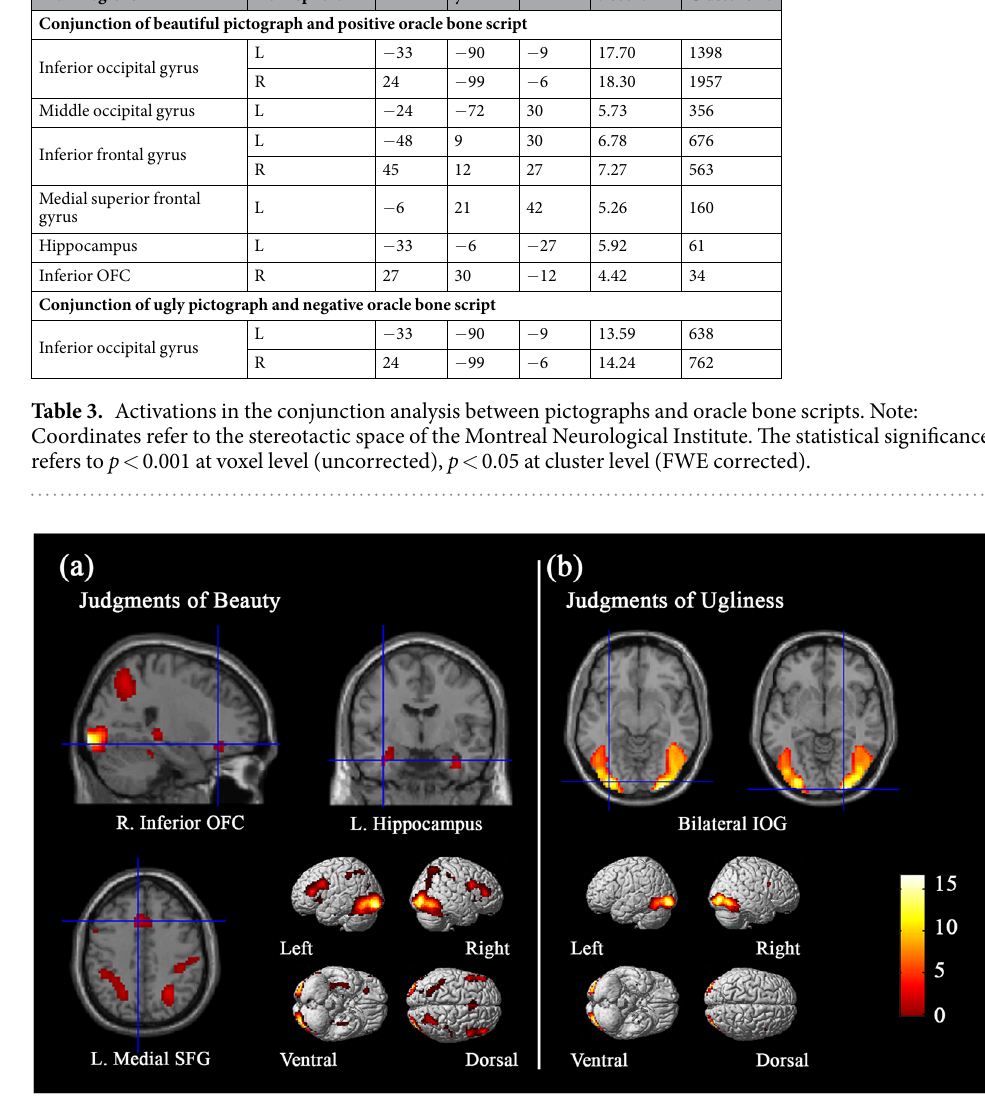
Figure 3. The conjunction results of the judgments of beautiful items and ugly items across pictographs and oracle bone